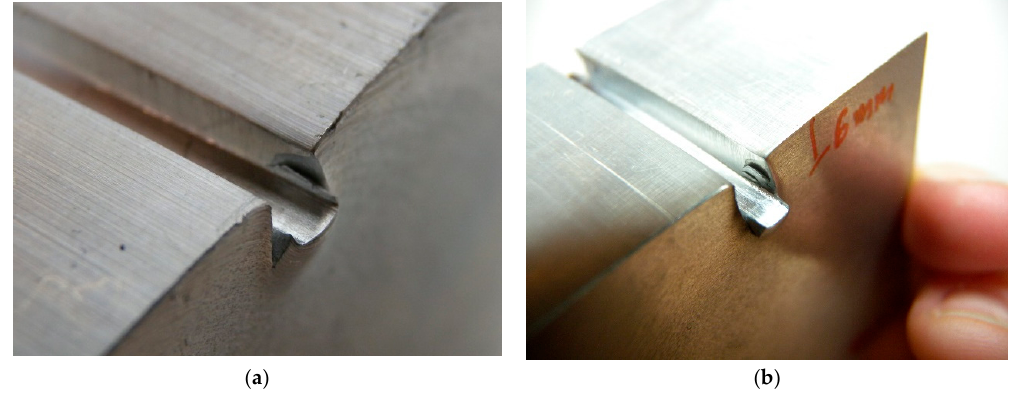
Figure 16. Cracks near the indenter boundary on specimen: E17 ( a ); and E23 ( b ) after indentation.